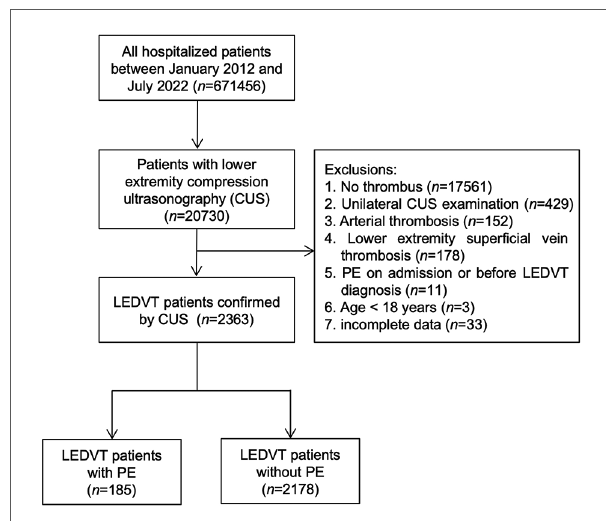
FIGURE 1 Flowchart of patient inclusion and exclusion. CUS, compression ultrasonography; PE, pulmonary embolism; LEDVT, lower extremity deep venous